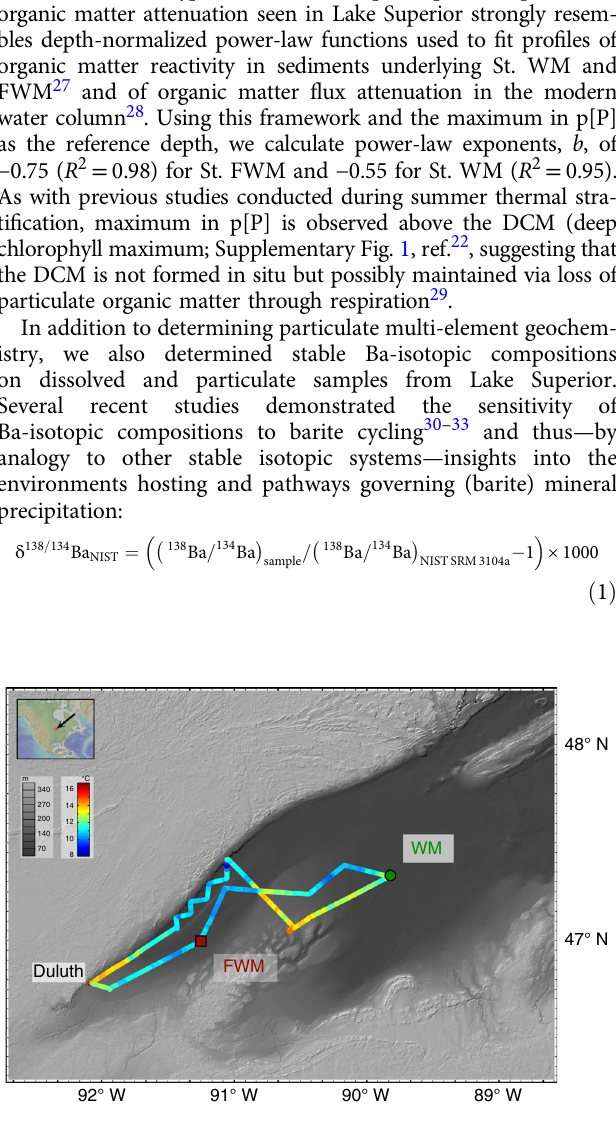
Fig. 1 Map showing cruise track, underway temperature, and sampling locations in Lake Superior. Dissolved and particulate samples were collected at FWM (46°59 ′ 54.7 ″ N, 91°14 ′ 46.5 ″ W; 144 m water depth; 26 August 2015) and WM (47°19 ′ 53.8 ″ N, 89°49 ′ 17.0 ″ W; 180 m water depth; 27 August 2015) aboard the R/V Blue Heron (cruise BH15-11, Duluth MN – Duluth MN). Map drafted using GeoMapApp (http://www. geomapapp.org); Lake Superior bathymetry from National Centers